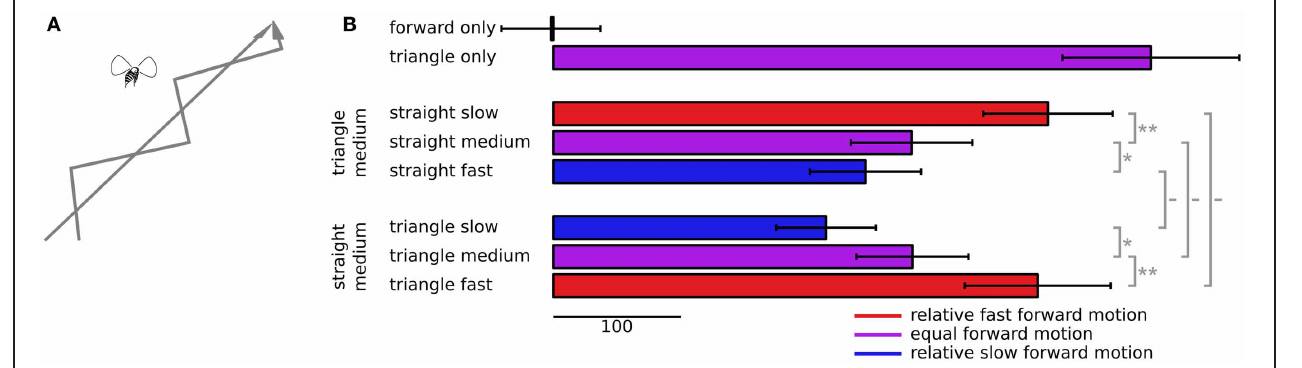
straight forward only moving dots varied between slower, the same, or faster than the slipping dots. The three bars on the bottom show the correlations when the straight forward moving dots advanced at a medium speed, and the triangular waveform slipping dots varied between slower, the same, or a faster speed. The sideways motion of the slipping dots remained the same in each case. The colors of each bar indicate the relative forward speed of the slipping dots, red for faster, blue for slower, and purple when the average dot speed was equal. The gray bars to the right show the results of paired t -tests, with symbols—for no significance, ∗ for P < 0 . 05, ∗∗ for P < 0 . 01.